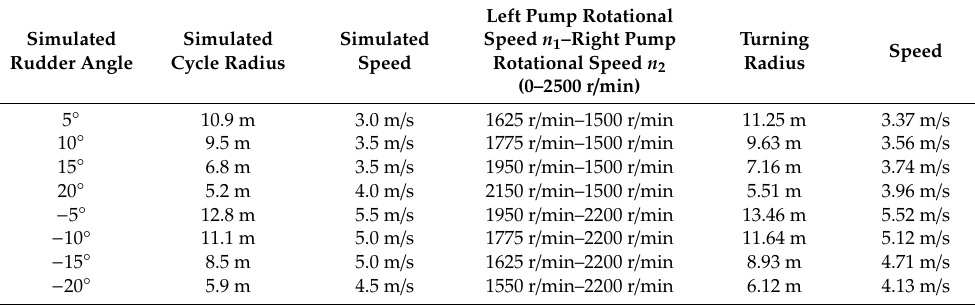
Table 1. Mapping relations between rudder angle and rotational speed.